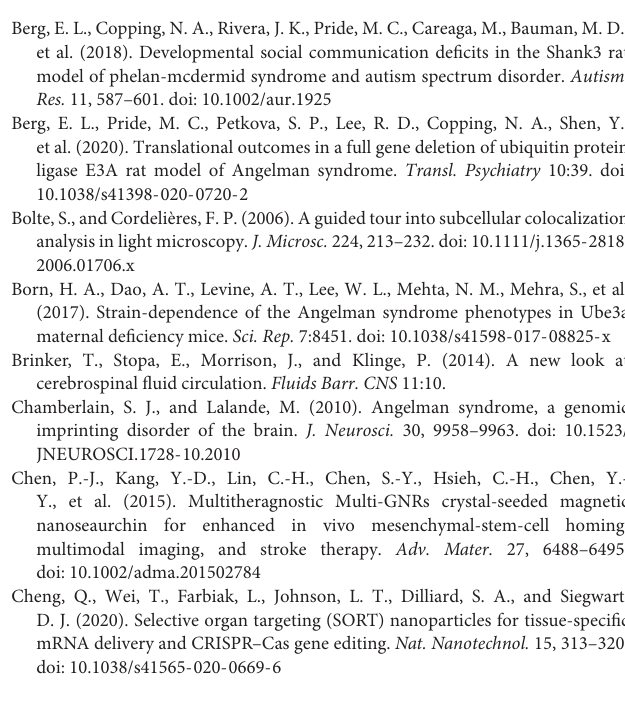
Scr-MSC, and ZF-MSCs are positive for MSC surface marker CD29b. (C) NT MSC, Scr-MSC, and ZF-MSCs are negative for platelet endothelial adhesion molecular marker CD31. (D) NT MSC, Scr-MSC, and ZF-MSCs are negative for differentiated hemopoietic cell marker CD45b. (E) NT MSC, Scr-MSC, and ZF-MSCs are negative for vascular endothelial marker CD105. (F) NT MSC, Scr-MSC, and ZF-MSCs are enriched for mouse MSC marker Sca-1. Supplementary Figure 4 | Intracranial injection of ZF-MSC demonstrated motility from the parenchyma, related to Figure 4 . (A) NT-MSC IC was observable within the mouse brain one week following injection and detected moving towards the lateral ventricles along the corpus callosum (A1) . The white box denotes inlet of an image in panel (A1) . Dashed white lines indicate the presence of injected MSC due to distinct morphology in contrast to mature NeuN + (red) neurons and nuclear Hoechst (blue) labeling. (B) ZF-MSC IC (green) was observable within the mouse brain following injection and detected moving along the corpus callosum towards the lateral ventricles (B1) . A white box denotes an inlet of image in panel (B1) . (C) ZF-MSCs IC were detectable across multiple regions of the brain, including the forebrain (C1) , site of injection along the corpus callosum (C2) , anterior to the hippocampus (C3) , along the third ventricle–ventral (C4) and posterior (C5) to the hippocampus, in the visual cortex (C6) , along with the cerebellum (C7,C8) , and within the lateral ventricles (C9) . Scale bar = 500 µ m (A–C) , 50 µ m (A1,B1,C1–C9) . Supplementary Figure 5 | Cisterna magna injection of ZF-MSC demonstrated motility to the CSF one week following injection, related to Figure 4 . (A) Cisterna magna (CM) injected ZF + (green) were detectable along the somatosensory cortex (A1) and were distinct from surrounding NeuN + (red) neurons and other Hoechst (blue) labeled cells. (B) ZF-MSC injected via the CM were detectable across multiple regions including the cortex (B1) , cerebellum (B2–B4) and along hypothalamic regions (B5–B6) . (C) ZF-MSC injected via the CM were detectable within the mouse spinal cord. Scale bar = 500 µ m (A–C) , 50 µ m (A1,B–B6) . Supplementary Figure 6 | YFP transcript expression is not altered with response to ZF, related to Figure 5 . (A) No observable changes in the 3 (cid:48) Ube3a-Ats transcript was observed in the cortex, hippocampus, midbrain, or cerebellum in 3-weeks post ZF-MSC treatment in Ube3a + / yfp mice. (B) No observable changes in the 5 (cid:48) Ube3a-Ats transcript was observed in the cortex, hippocampus, midbrain, or cerebellum in 3-weeks post ZF-MSC treatment in Ube3a + / yfp mice. Error bars indicate ± standard error of the mean. Dots indicate individual